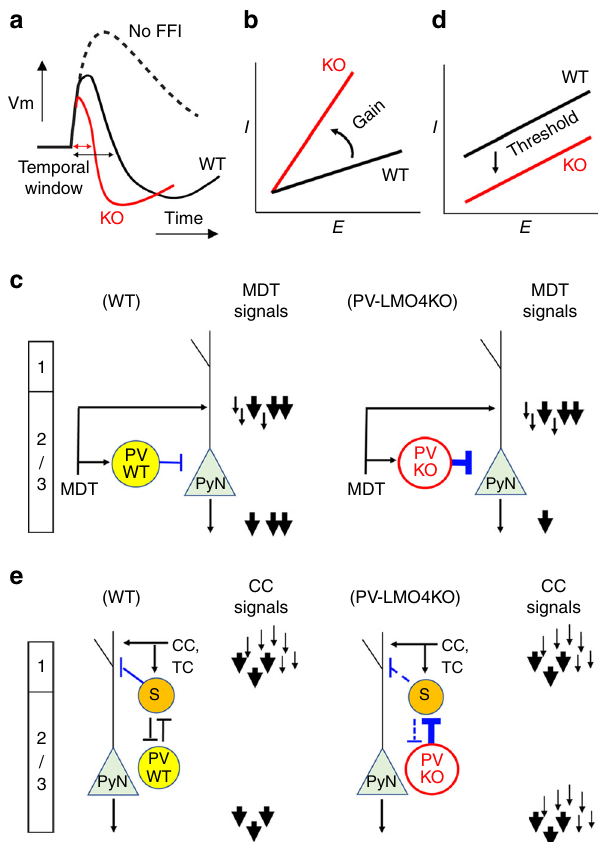
Fig. 9 Diagram illustrating how homeostatic maladaptation of the inhibitory circuits via feedforward inhibition (FFI) might alter information processing in PV- Lmo4 KO mice to account for ASD-like behaviors. This model implicates over- fi ltering of mediodorsal thalamocortical (MDT) inputs yet inability to fi lter cortical-cortical (CC) signals. a Stronger and faster PV-mediated peri-somatic FFI narrows the temporal window of L2/3 pyramidal neurons to integrate excitatory inputs, resulting in a divisive change in the gain between the excitatory (E) and inhibitory inputs (I) ( b ). c Thus, fewer MDT excitatory inputs would succeed in eliciting action potentials at L2/3 pyramidal neurons (PyN); not only background noise (thin black arrows), some valid signals (thick black arrows) would be also fi ltered away. d Adaptive reduction of SST-mediated dendritic inhibition lowers the activation threshold of L2/3 pyramidal neurons, as re fl ected by a subtractive change between the E-I. This would compromise the ability of the L2/3 pyramidal neuron population to respond/distinguish the range of stimulus intensities from cortical-cortical inputs (CC) or projections from other higher-order thalamic nuclei (TC) (Fig. 6e). e In contrast to wild-type mice (PVWT), background noise (thin black arrows) would fail to be fi ltered in PV-LMO4KO (PVKO) that MD thalamocortical inputs would be less effective in acti- vating L2/3 pyramidal neurons (Fig. 9b, c). Indeed, we observed a 30% reduction in spike probability (Fig. 4n).